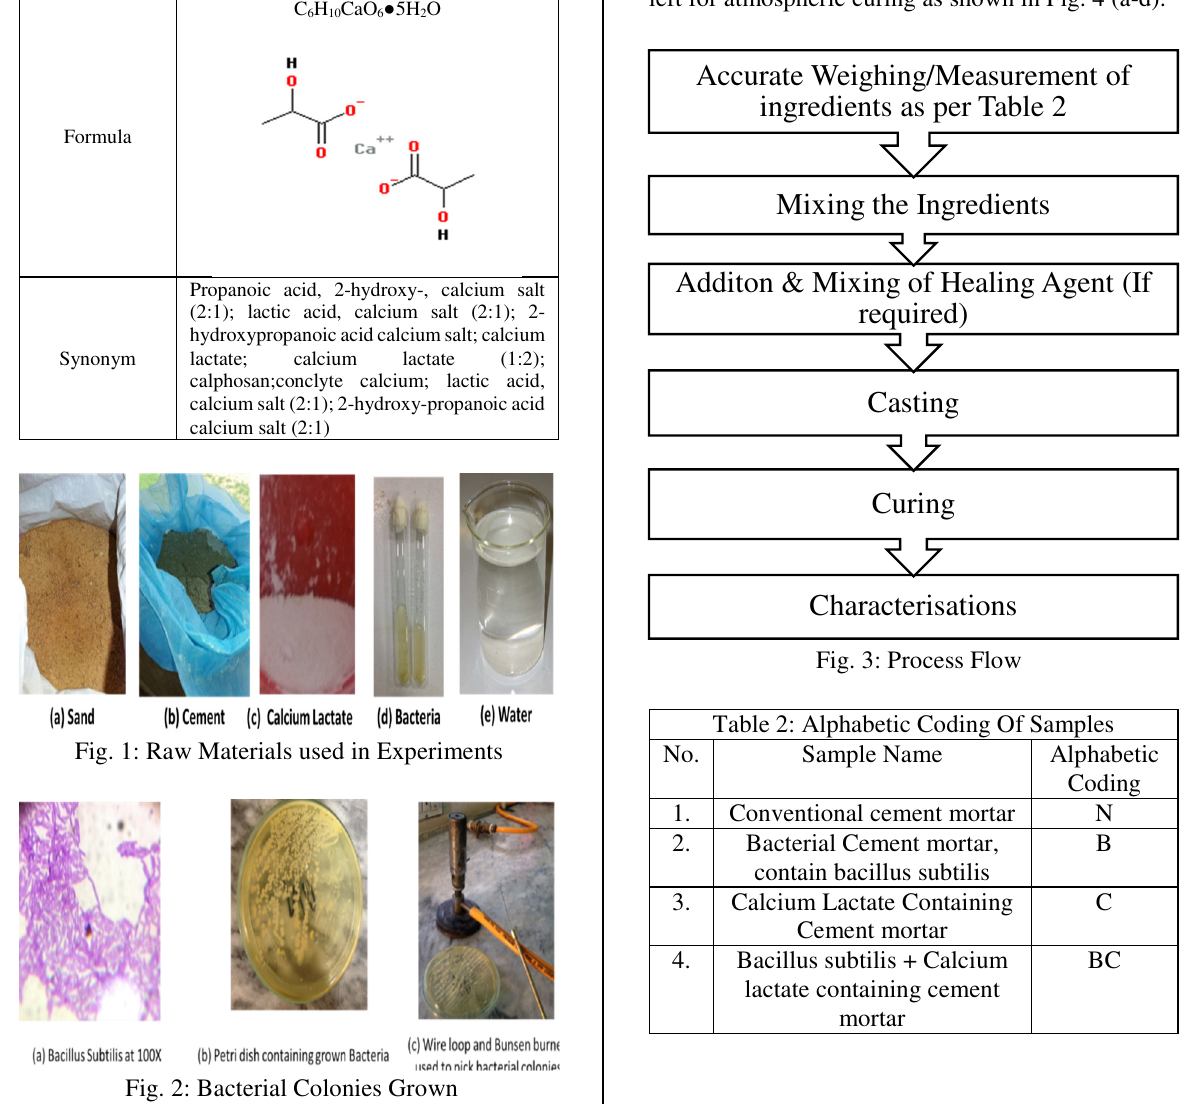
Table 1: Calcium Lactate Properties